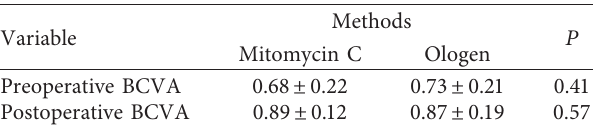
Table 4: Comparison between the two groups regarding pre- and postoperative